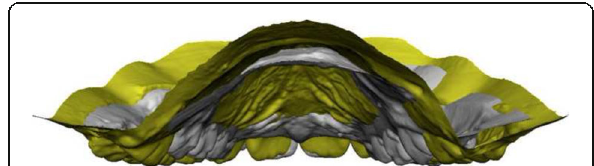
Fig. 8 Comparison between a patient with DMC (grey) and a control subject (yellow): posterior